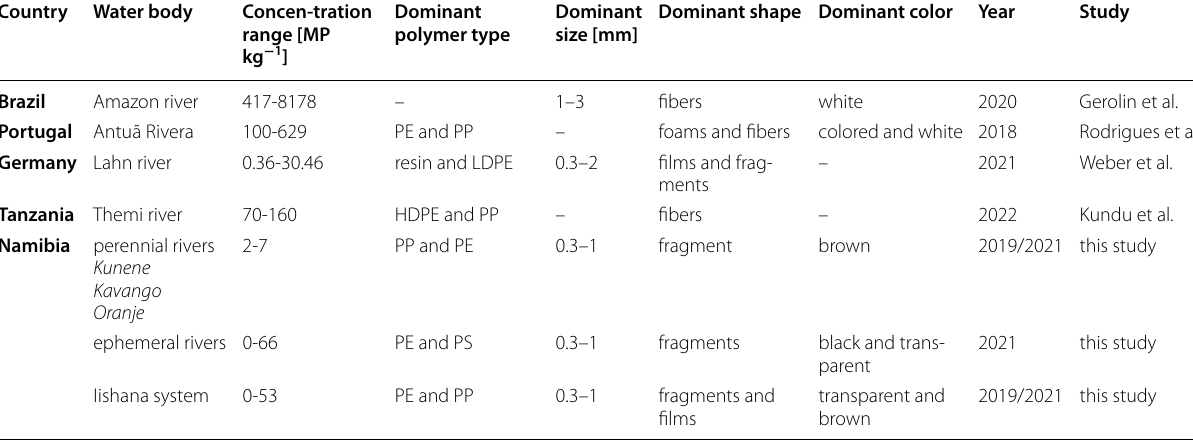
Table 3 Comparison of MP concentrations in different